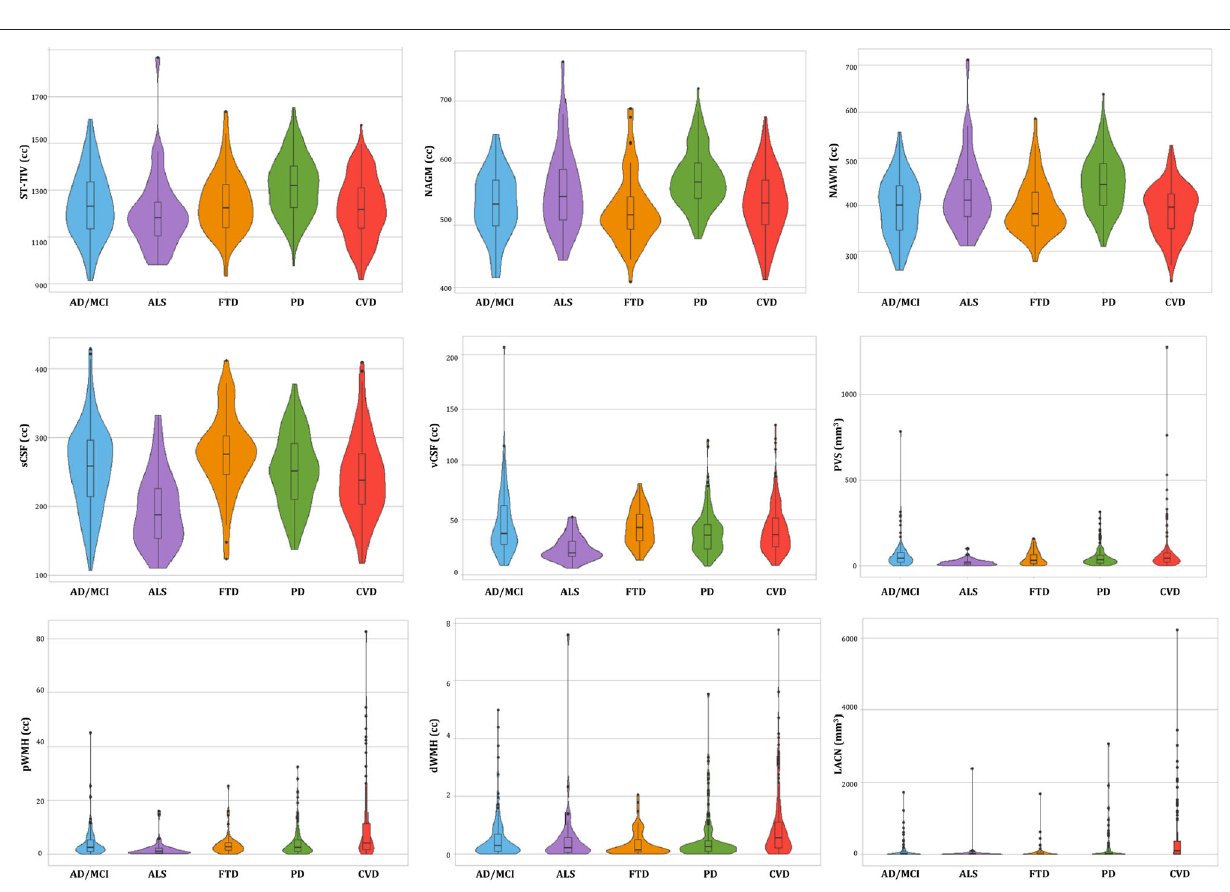
disease. Given the skewed, non-normal distribution of WMH (even after head-size correction), WMH volumes are typically transformed (e.g., log) prior to standard parametric